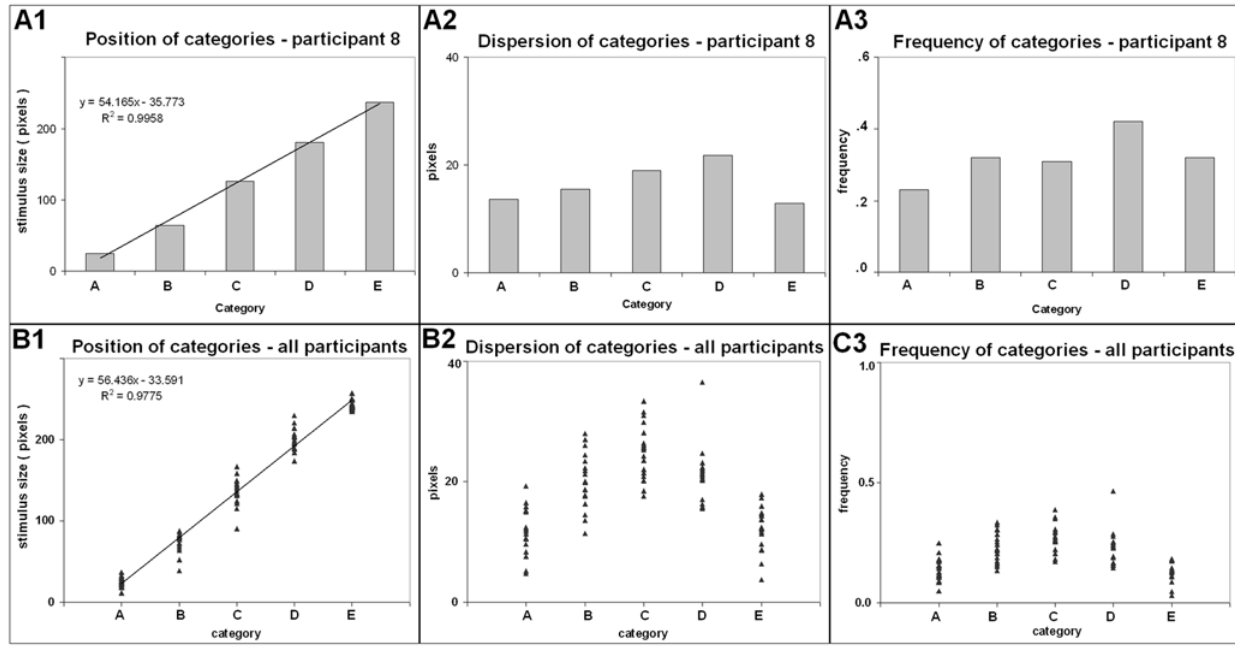
Figure 5. Descriptive statistics of the categories of the ratings. From left to right : 1) position (center of mass), 2) dispersion (standard deviation), 3) frequency of the rating (across all stimulus sizes). Horizontal : categories. Vertical : stimulus size (diameter in pixels) for position and dispersion, number of stimuli for frequency. A: One participant. B: Whole group. Scatter plots, each dot represents a Category x Participant combination.